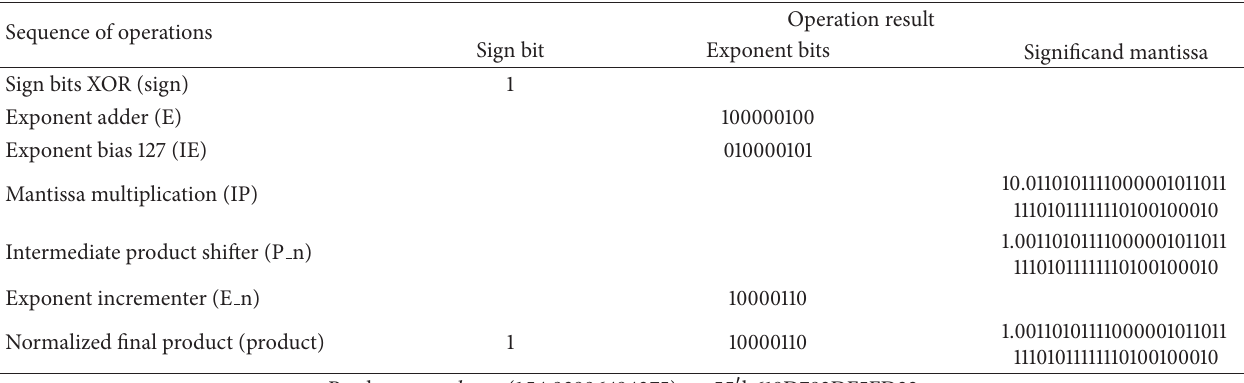
Table 4: Sequence of operations and the corresponding results.